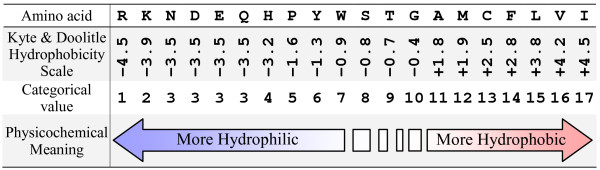
An illustration of ordered categorical values for hydrophobicity scales for the original or substituted amino acids.